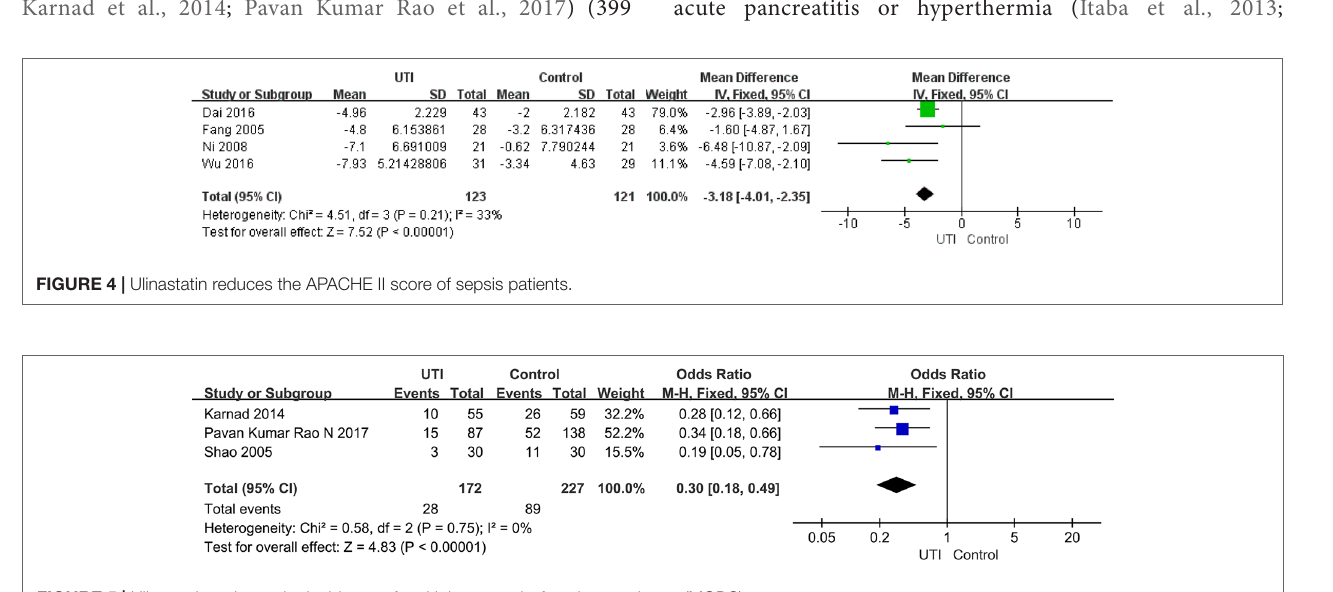
FIGURe 5 | Ulinastatin reduces the incidence of multiple organ dysfunction syndrome